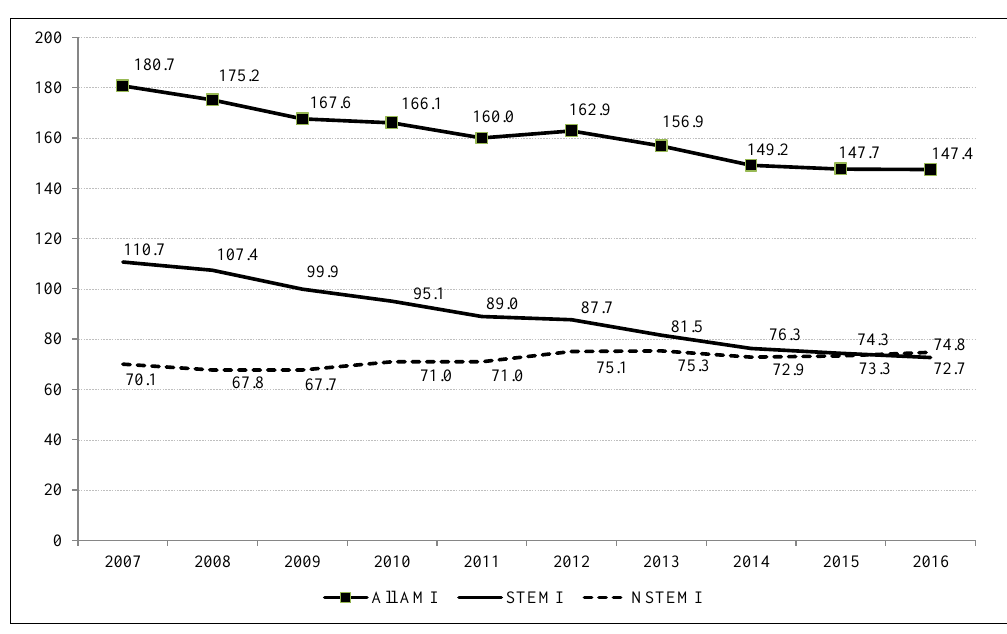
and the in-hospital mortality rate for STEMI was 12.2% (Table